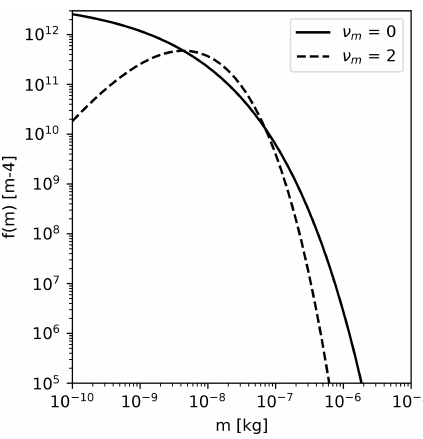
Figure 2. Particle distribution as a function of mass (PSD m ) with a mass density of q = 2 × 10 − 4 kgm − 3 and a number density of qn = 10 4 m − 3 illustrating PSDs with a different shape parameter µ m